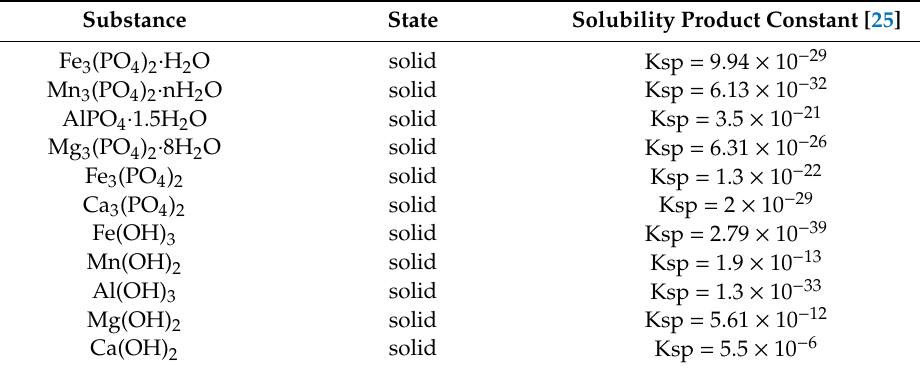
Table 2. Solubility product of precipitates that may appear in the reaction system (298.15 K).